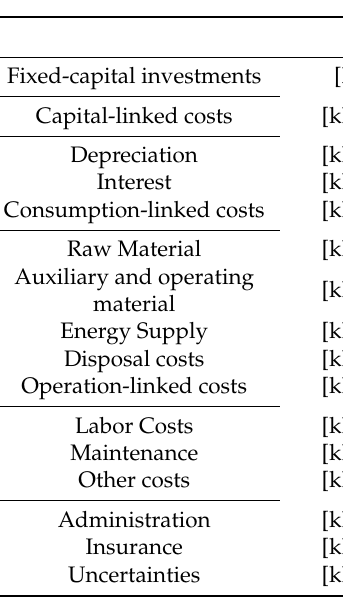
Table 6. Investments and annual costs of purification cascades 1 and 2.